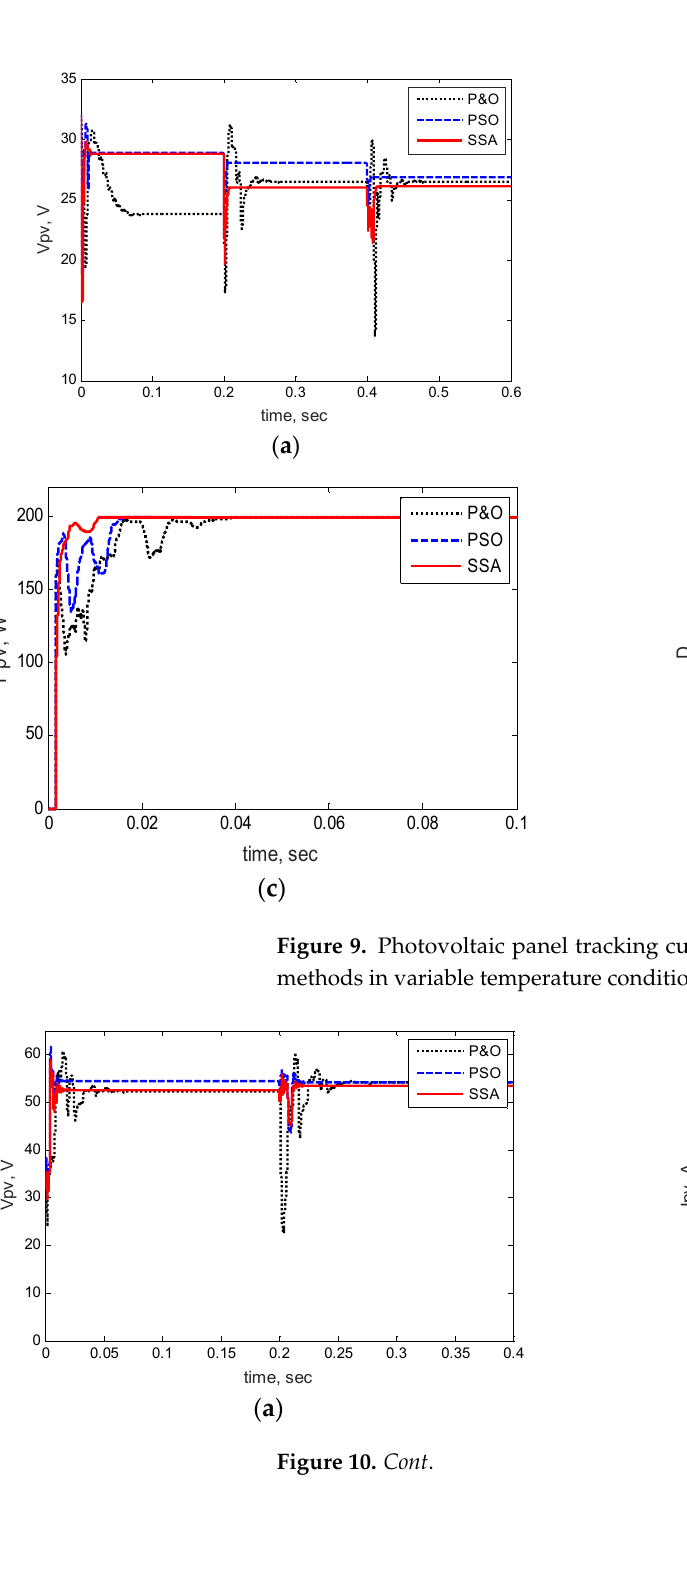
( d ) Figure 8. Photovoltaic panel tracking curves using the proposed method and P&O and PSO meth- ods in variable radiation conditions: ( a ) Vpv, ( b ) Ipv, ( c ) Ppv, ( d ) duty cycle. Figure 8 reveals that the performance of the SSA method compared to other methods in achieving the maximum power of the photovoltaic system was much higher in terms of convergence speed and accuracy, so few transient fluctuations were observed in the SSA method. Moreover, the results showed that the increase in radiation resulted in a decrease in the voltage and an increase in the current, increasing the PV panel’s output power. Due to this, the proposed method is more responsive to variable radiation condi- tions than P&O and PSO. 5.3. Simulation Results in Variable Temperature Conditions This section evaluates the effect of change in temperature on applying the proposed method to the MPPT problem. Here, the radiation intensity is considered constant at 1000 W/m 2 . The temperature changes occur in steps of 0.2 s, with each step’s values being 25,